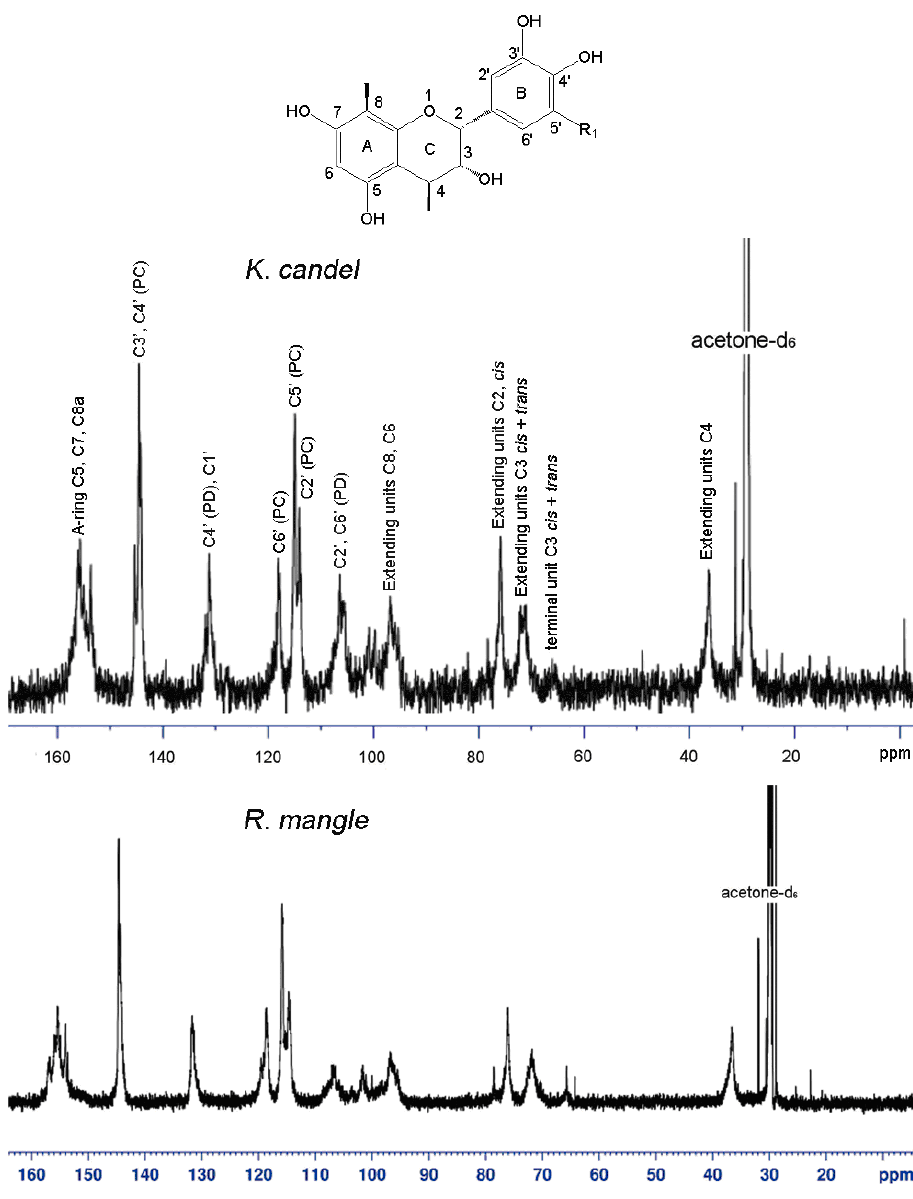
Figure 1. 13 C-NMR spectra (150 MHz) of condensed tannins from K . candel and R. mangle ; solvent, acetone- d /D O; room temperature. Identity of the structures: R 6 2 epicatechin; and R =OH, 1